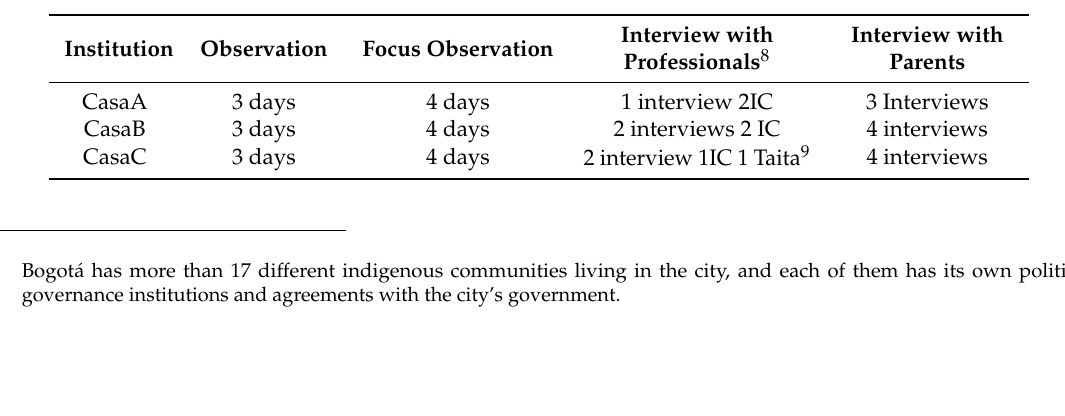
Table 2. List of the field and the data